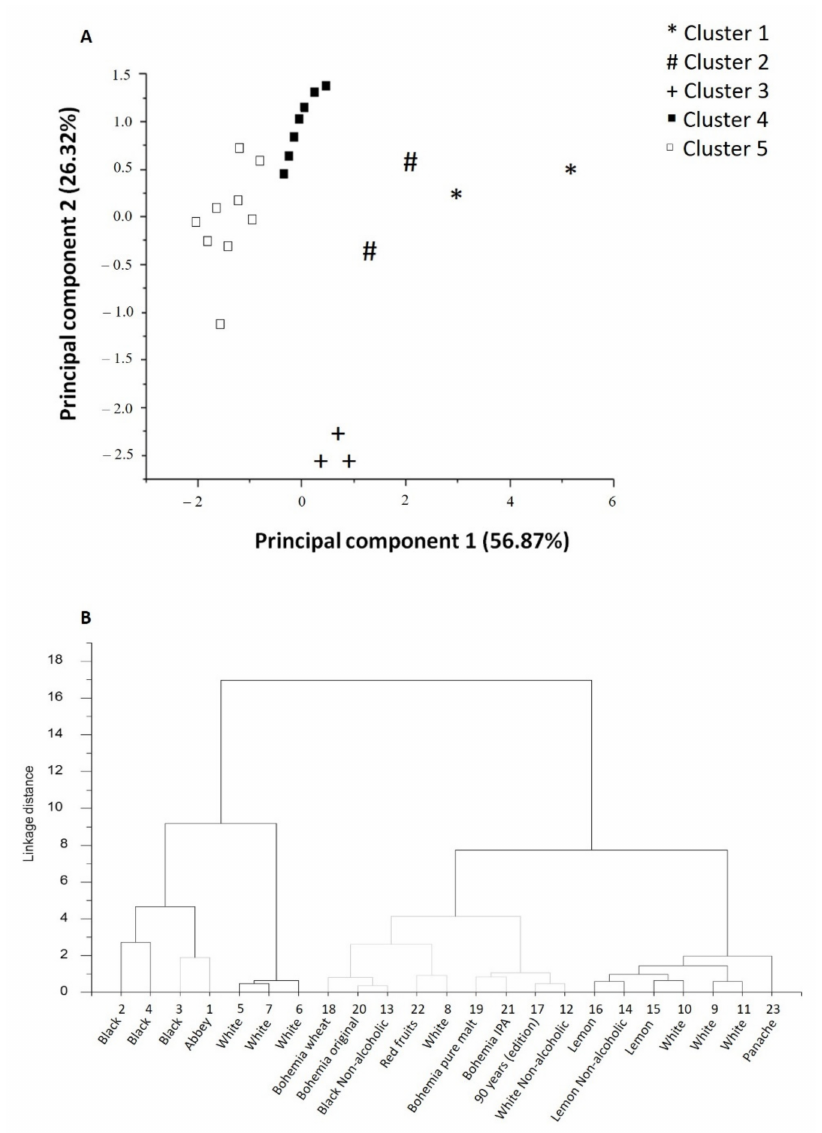
Figure 2. ( A ) Grouping resulting from the analysis of clusters. Different colors refer to different groups. The distribution of the samples is represented according to the values for CPs 1 and 2; ( B ) Dendrogram for beers obtained by hierarchical group